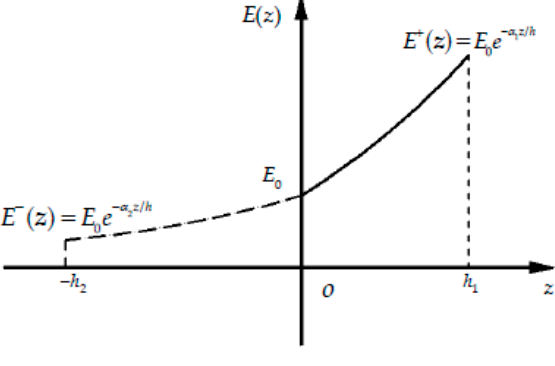
Figure 4. E + ( z ) and E − ( z ) when α 1 = − 2 and α 2 = − Figure 4. ( ) E z + and ( ) E z − when